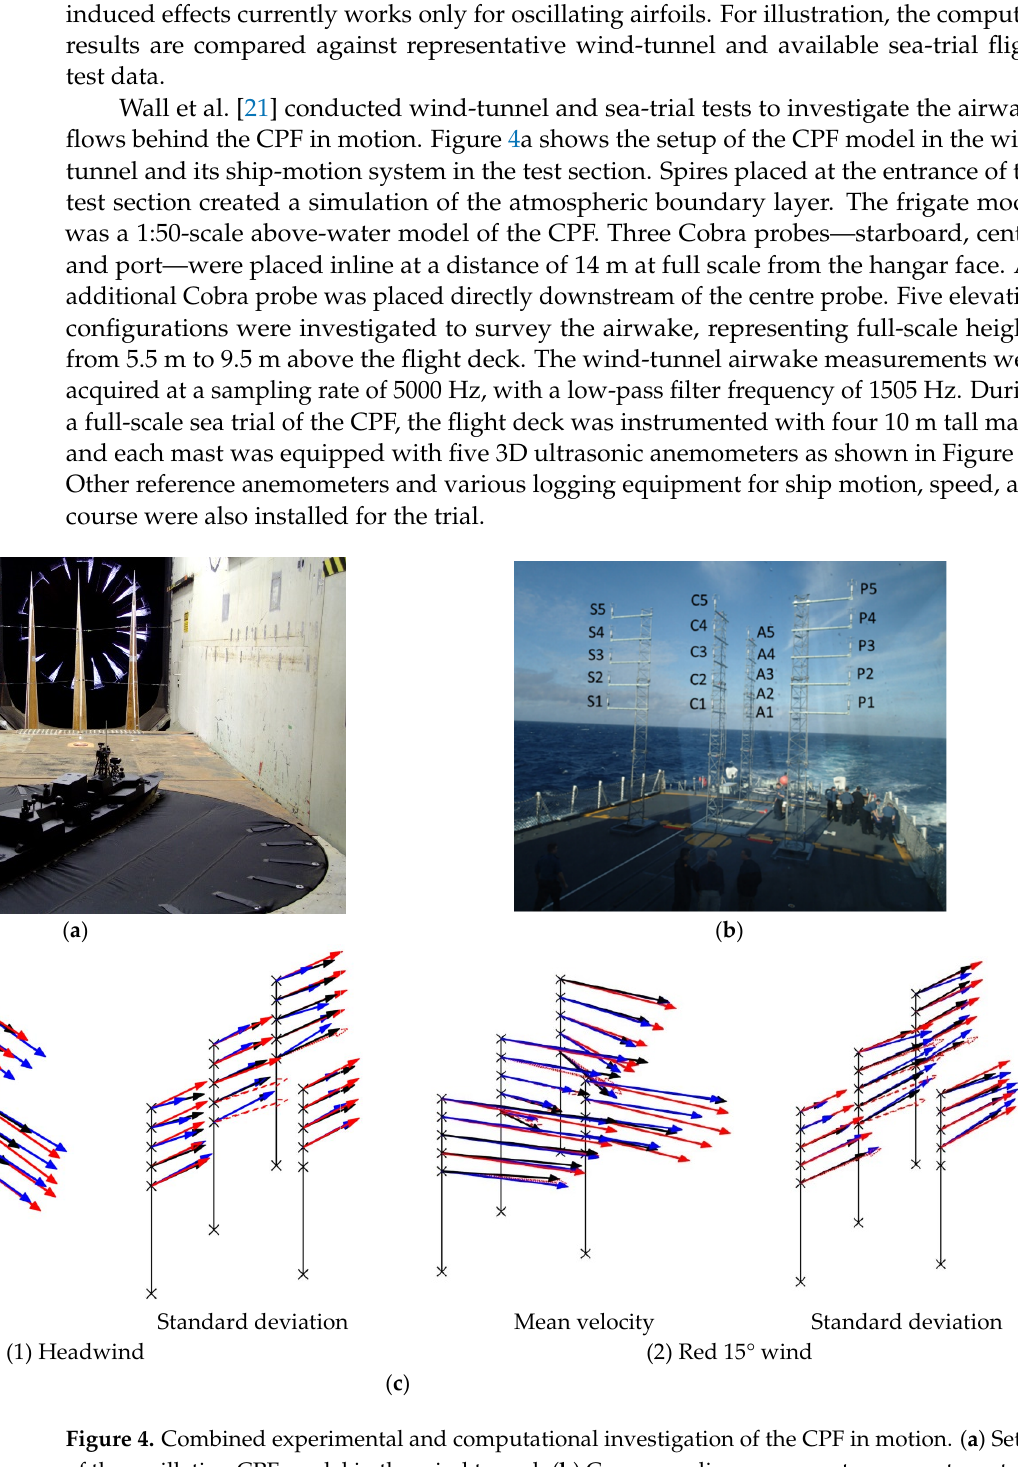
Figure 4. Combined experimental and computational investigation of the CPF in motion. ( a ) Setup of the oscillating CPF model in the wind tunnel. ( b ) Corresponding anemometer support masts on flight deck at sea trial. ( c ) Mean velocity vector and standard deviation in the CPF flight deck wake for roll conditions; red—wind tunnel, blue—CFD, black—sea